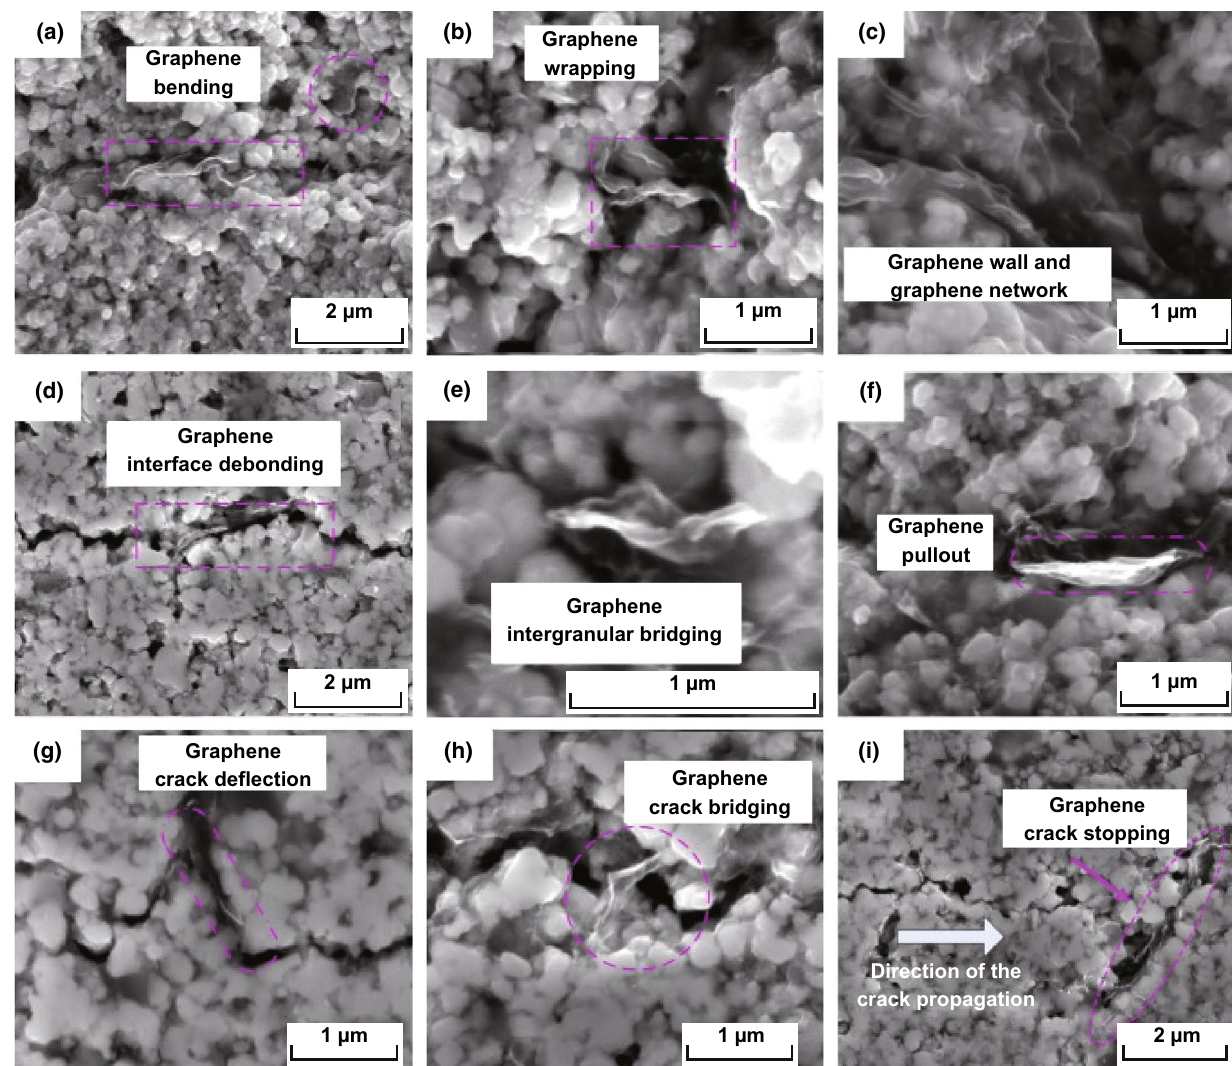
Fig. 16 Toughening mechanisms in WC‑based ceramics reinforced by MLG: a graphene bending, b graphene wrapping, c graphene wall and network, d graphene interface debonding, e graphene intergranular bridging, f graphene pullout, g graphene deflection, h crack bridging, and i crack stopping [178]. Figure panels reproduced from Ref. [178] with permission from Elsevier copyright